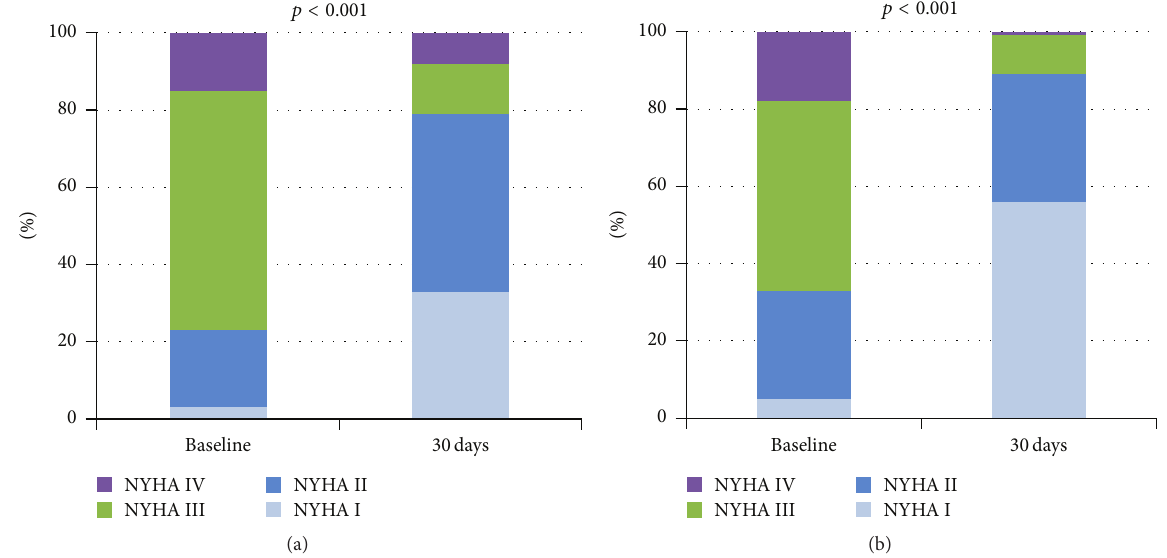
Figure 3: Postprocedural symptomatic improvement in patients with low-flow low-gradient severe aortic stenosis (LFLGAS) and those with non-LFLGAS. (a) LFLGAS patients. (b) Non-LFLGAS patients. NYHA indicates New York Heart Association functional class. 𝑝 ≤ 0.05 denotes a significant difference between patients with low-flow low-gradient severe aortic stenosis (LFLGAS) and those with non-LFLGAS.